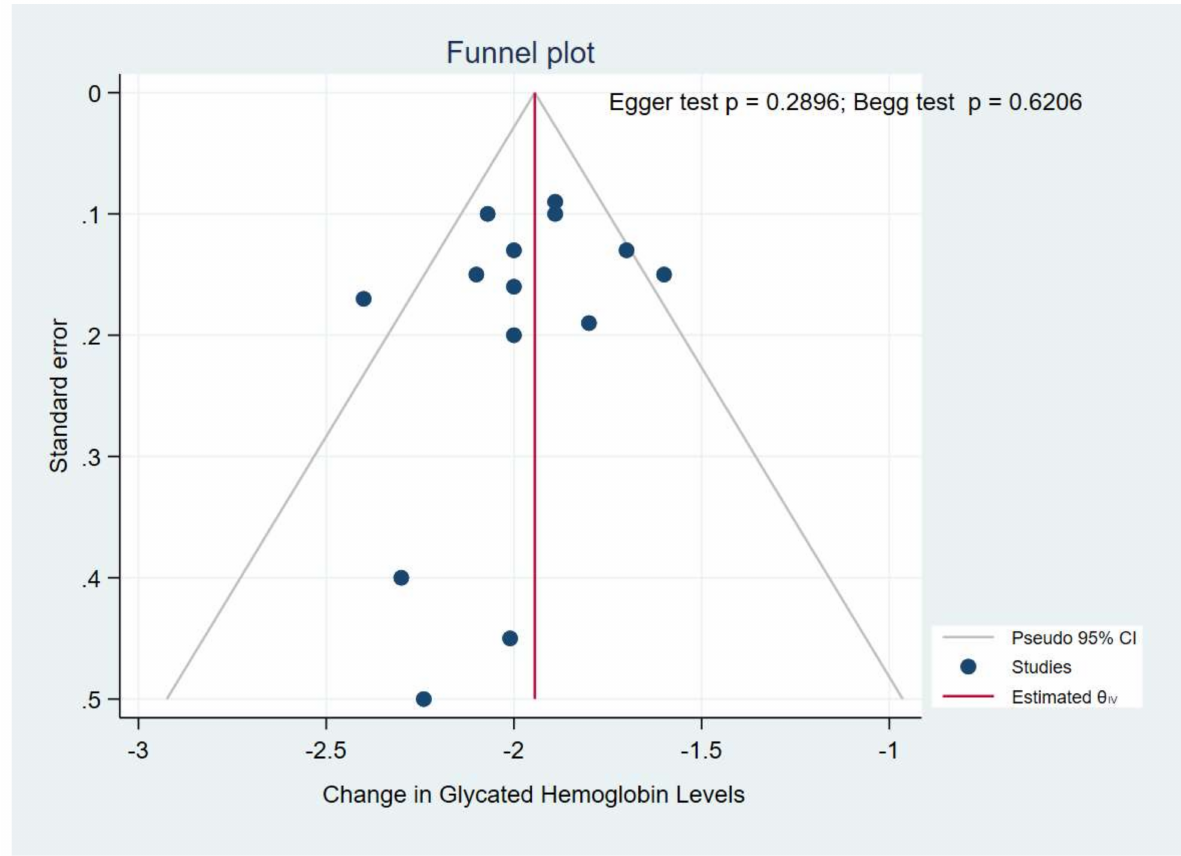
Figure 7. Funnel